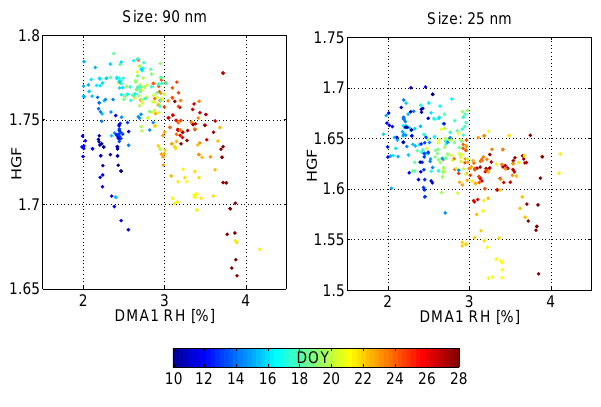
Fig. 6. Hygroscopic growth factors (HGF) of 90nm (left figure) and 25nm (right figure) particles as a function of the dry DMA1 RH. Additionally, the time (DOY January 2007) is presented with colour.